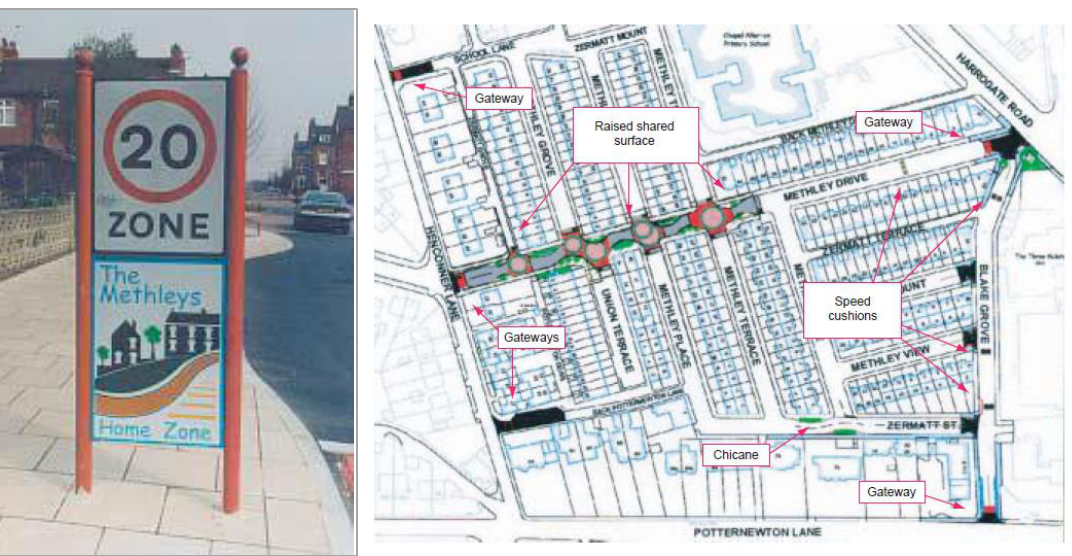
Figure 3 and Figure 4 Home zone sign (left), an example of a home zone implementation showing Methley Drive (right) (Layfield et al., 2003,